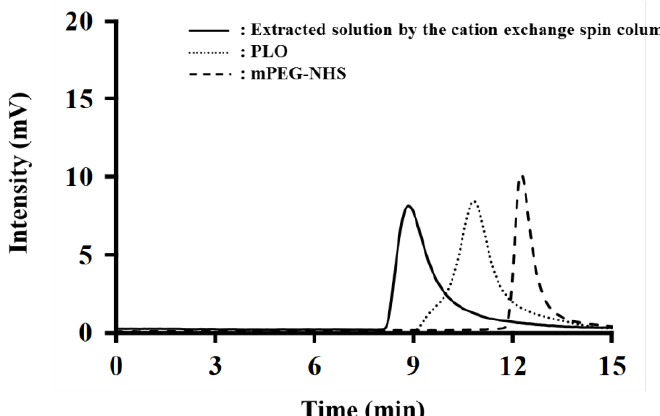
Figure 1. Synthesis scheme of polyethylene glycol modified poly- L -ornithine (PEG-PLO) using N -hydroxysuccinimide (mPEG-NHS). PLO and mPEG-NHS were mixed in a 1:10 molar ratio. The mixture was stirred overnight at room temperature (r.t.).